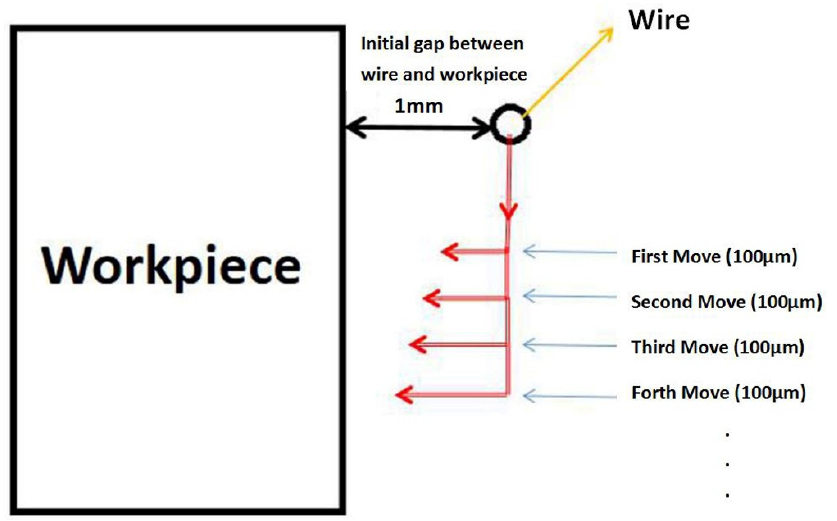
Figure 3. Top view of the adjustments for tracking the first craters that appear on the surface.